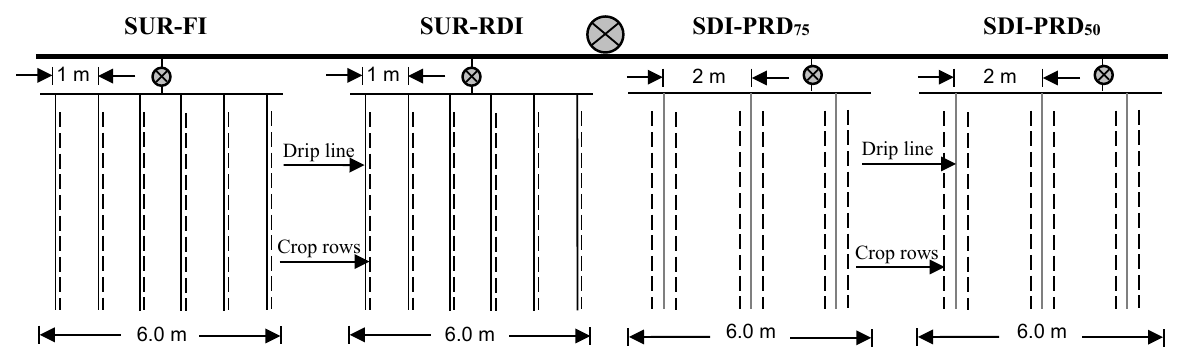
Fig. 1: Layout of the experimental plots showing drip line positions and arrangement of tomato plants under different drip irrigation treatments. FI = full irrigation; PRD = partial root zone drying; RDI = regulate deficit irrigation; SDI = subsurface drip irrigation; SUR = surface drip